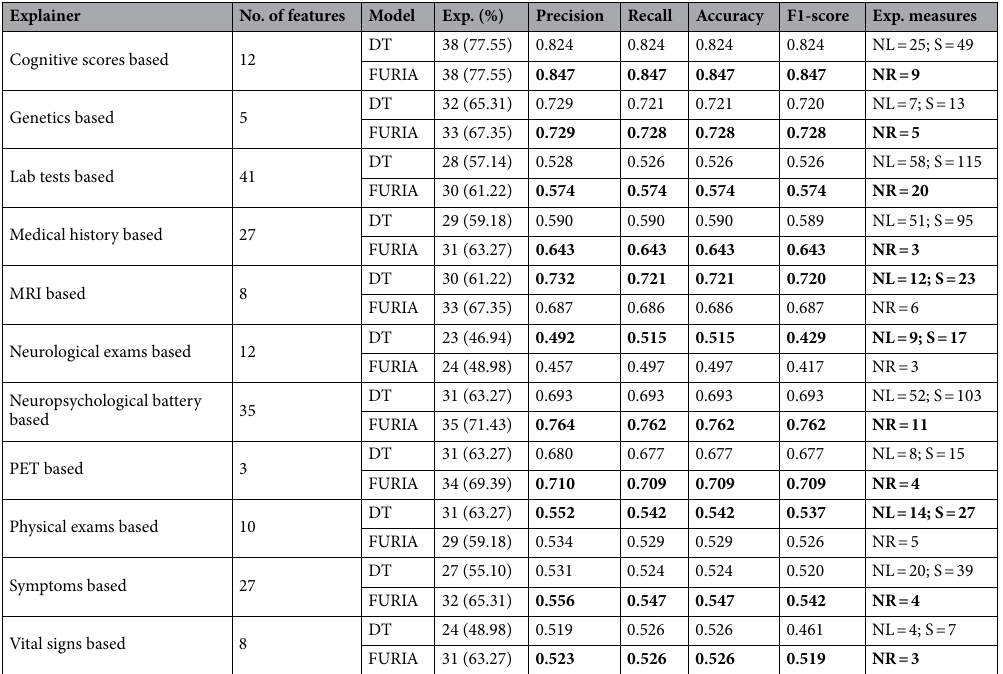
Table 10. The performance of the explainers on different modalities (Second Layer). Exp. measures, explainability measure; NL, number of leaves; S, size of the tree; NR, number of rules; Exp. (%), the number of explained cases (percentage of coverage); values in bold indicate the best